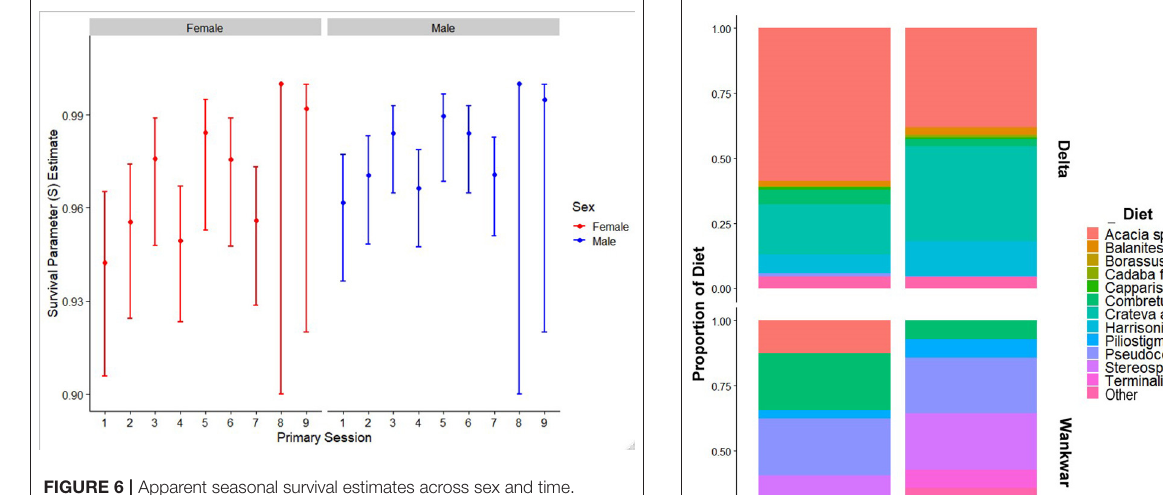
FIGURE 6 | Apparent seasonal survival estimates across sex and time. Parameter estimates are generated from the best support mult-state mark recapture model with error bars representing 95% CI.